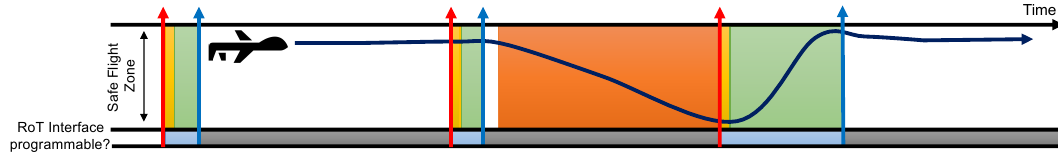
Figure 7. An example of a UAV system operating under the ReSecure framework [49]. The black line coming out from the UAV indicates the distance before it gets out of the safe flight zone. The red arrows annotate the triggering of the restarting points by the RoT. The blue arrows annotate the exit of the SEI (and that the next restart time is scheduled in RoT). We use different colors to illustrate the different phases of the system operation: white , the main flight controller is in charge and system is not compromised; yellow , the system is restarting; green , SEI is active, the safety controller is running and the next restart time is being calculated; orange , the system is compromised and the adversary is in charge; and blue/gray , the time spans when the (RoT) interface is available and unavailable,